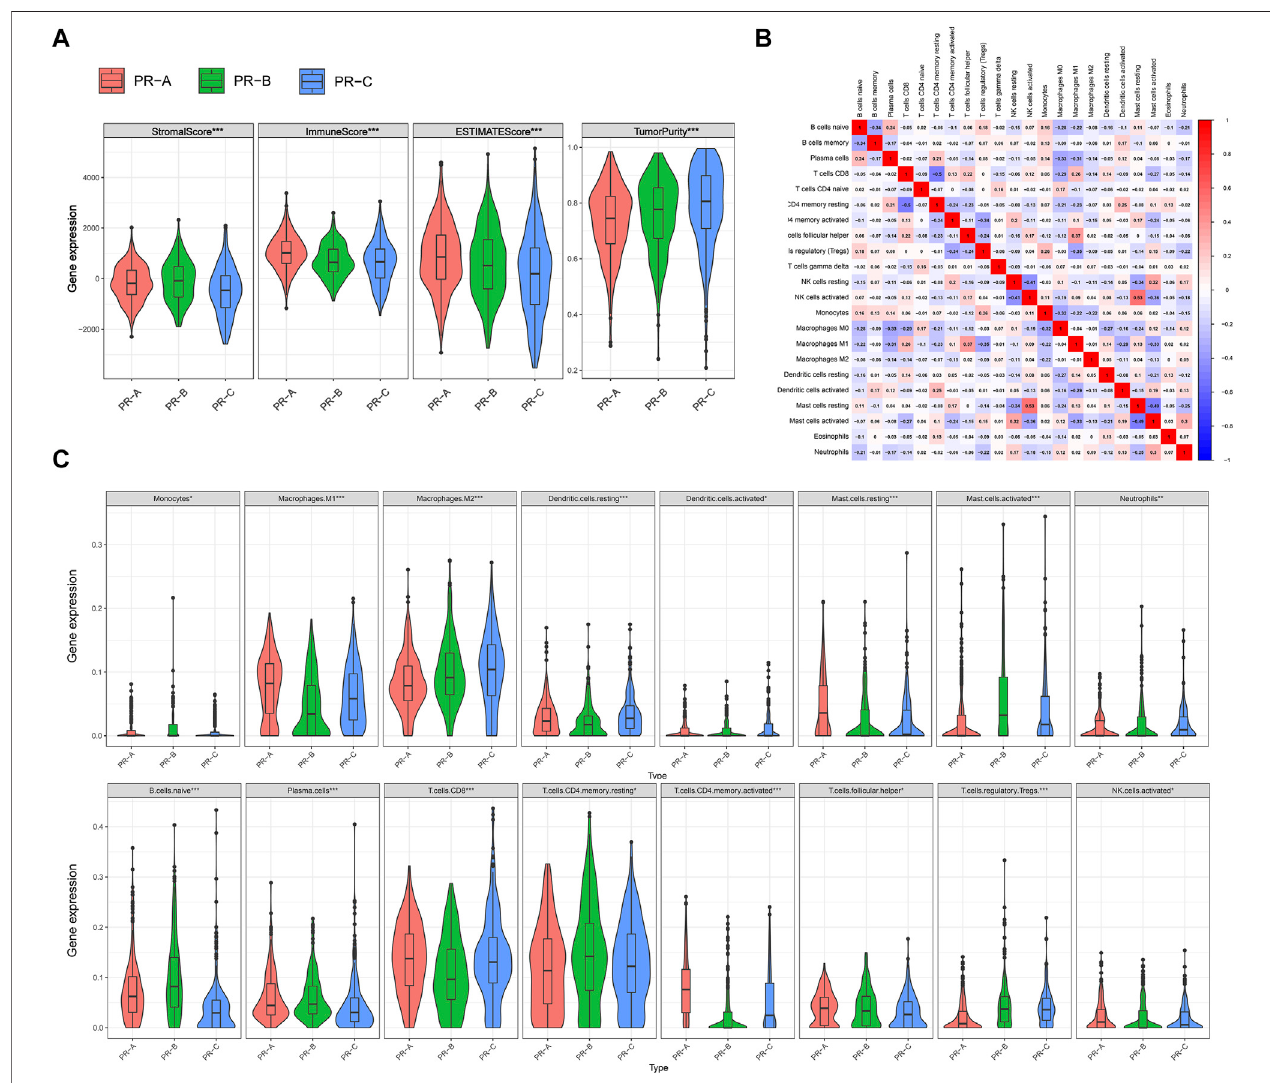
FIGURE 3 | Distinct three pyroptosis-related (PR) clusters showed diverse tumor microenvironment (TME) cell in fi ltration. (A) The level of stromalScores, immuneScores, ESTIMATEScores, and tumorPurity calculated with ESTIMATE in three PR clusters based on the three eligible colon cancer (CC) cohorts of gene- expression data (GSE39582, GSE33113, and The Cancer Genome Atlas — Colon Adenocarcinoma (TCGA-COAD)). (B) Heatmap showing the correlation of TME cell in fi ltrationcalculatedwithCIBERSORT. (C) ThelevelofTMEcellin fi ltrationinthreePRclusters:PR-A,red;PR-B,green;andPR-C,blue.Theupperandlowerends oftheboxesrepresenttheinterquartilerangeofvalues.Thelinesintheboxesrepresentmedianvalue,andblackdotsshowoutliers.Theasterisksrepresentthestatistical p -value. ANOVA test. * p < 0.05; ** p < 0.01; *** p < 0.001; p ≥ 0.05, not signi fi cant.